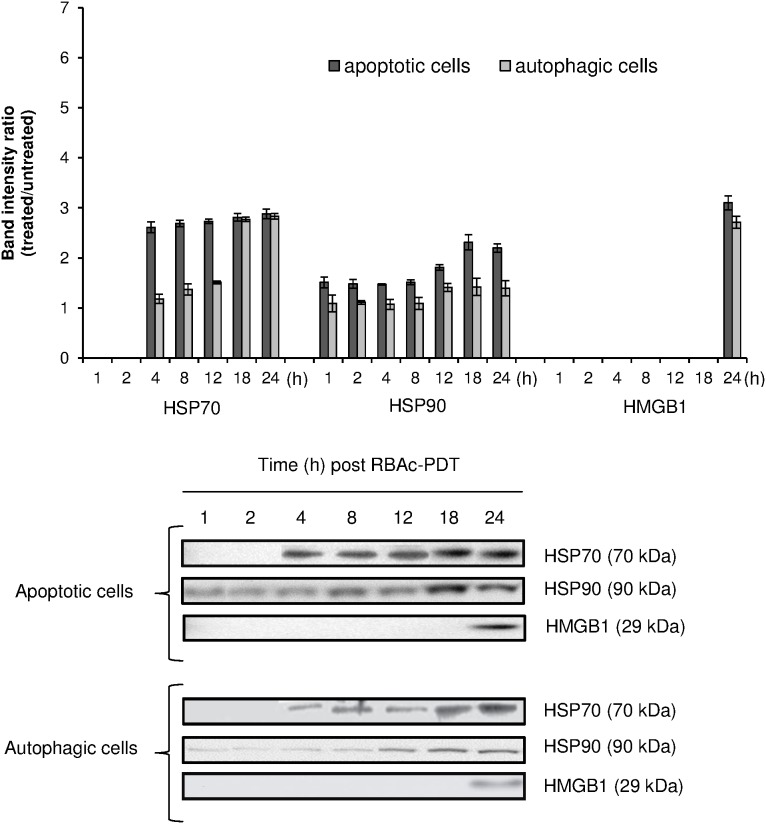
RBAc-PDT induces an early release of HSP70 and HSP90 and a late and passive release of HMGB1 in HeLa cells.Kinetic of released HSP70 and HSP90 was performed by Western blot of electroblotted to nitrocellulose membrane SDS-PAGE of the conditioned media proteins (30 µg protein/lane) of RBAc-PDT treated HeLa cells (10−5 M RBAc, 1 h, 1.6 J/cm2, 90 sec) in the presence of 3-MA (10 mM) and Nec-1 (300 µ) (apoptotic cells) and in the presence of z-VAD-FMK (20 µM) and 3-MA (10 mM) (autophagic cells) at indicated time intervals. Monoclonal antibodies against HSP70 (70 kDa), HSP90 (90 kDa) and HMGB1 (29 kDa) were used. The amount of HSP70, HSP90 and HMGB1 proteins was reported as band intensity ratio (treated/untreated) measured by densitometer analysis. Actin is absent in the conditioned media proteins. The data are the mean ± SD of three independent experiments. The values (4–12 h) of ecto-HSP70 of apoptotic cells are significantly different (p<0.05) with respect to autophagic cells. HSP90 and HMGB1values of apoptotic cells were always significantly different (p<0.05) with respect to autophagic cells. HSP70, HSP90 and HMGB1 values of apoptotic and autophagic cells were always significantly different (p<0.05) with respect to untreated cells. One representative Western Blot is shown out of the three independent experiments performed.